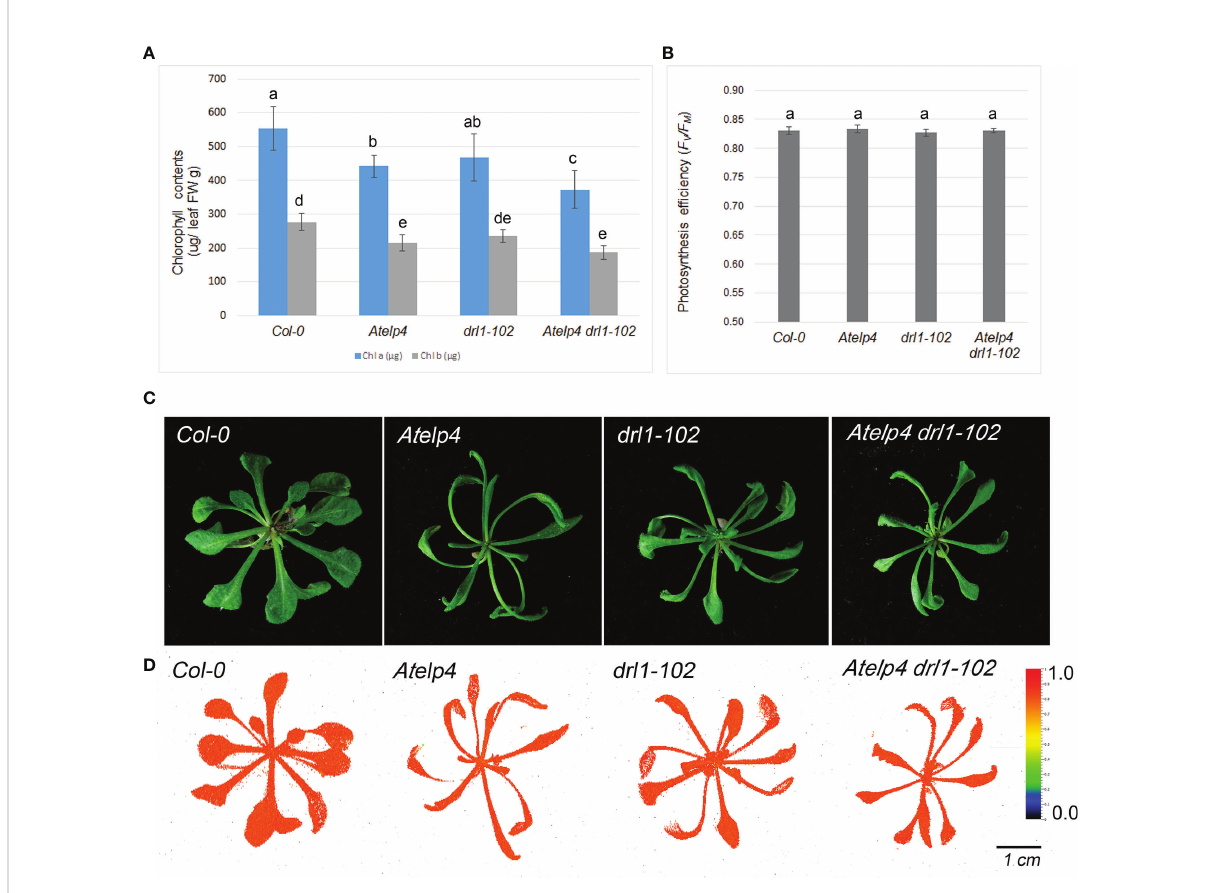
FIGURE 8 Photosynthesis ef fi ciency and chlorophyll contents of Atelp4 and drl1-102 single and double mutants. (A) Chlorophyll content. (B) Photosynthesis ef fi ciency ( Fv / Fm ratio) (n = 10) measured by FluorCam, (C) phenotypes of plants, and (D) false color image of photosynthesis ef fi ciency ( Fv / Fm ratio) captured by FluorCam. The color box in panel D means photosynthesis ef fi ciency from 0 (minimum value, blue) to 1.0 (maximum value, red). Data are shown as means of eight plants with SEs. Different lowercase letters in panels A and B indicate signi fi cant differences between plants, according to ANOVA and Tukey ’ s multiple range test (p-value